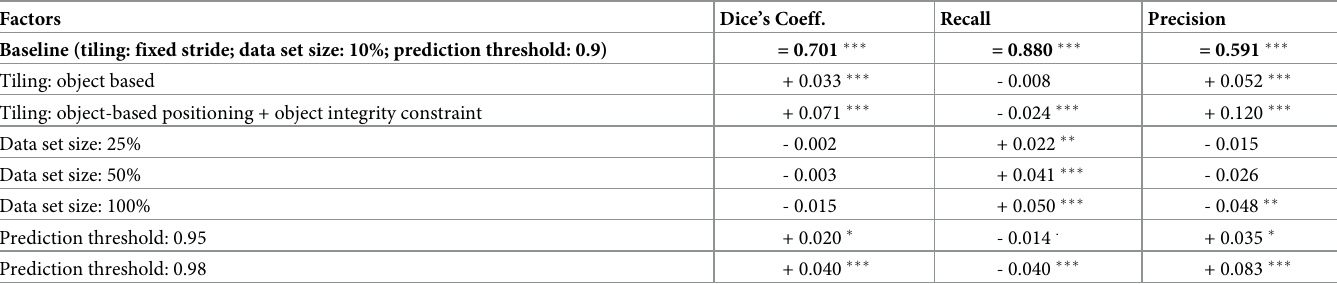
Table 3. Effects of tiling method, training data set size and prediction threshold on the segmentation performance of the Mask R-CNN models. Factors Dice’s Coeff. Recall Precision